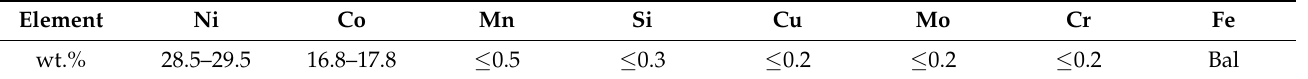
Table 2. Main components of 4J29 fungible